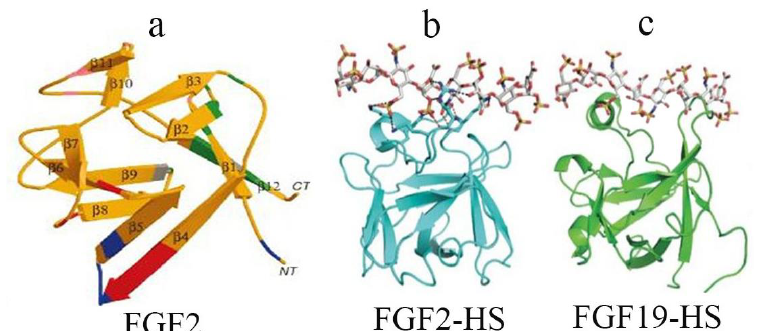
Figure 2. Comparison of the crystal structures of FGF2 and FGF19 provides the structural basis for the low affinity of endocrine ligands for HS. ( a ) Three-dimensional structure of FGF2, a prototypical member of the FGF family. A ribbon diagram of FGF2 is shown; β strands are labeled 1– 12. The heparin-binding region (pink) includes residues in the loop between β strands 1 and 2 and in β strands 10 and 11. Residues that contacted the FGFR are shown in green (the region contacting Ig-domain 2 of the receptor), blue (contacting Ig-domain 3) and red (contacting the alternatively spliced region of Ig-domain 3); ( b ) the crystal structures of FGF2 and heprin; ( c ) the crystal structures of FGF19 and heprin.